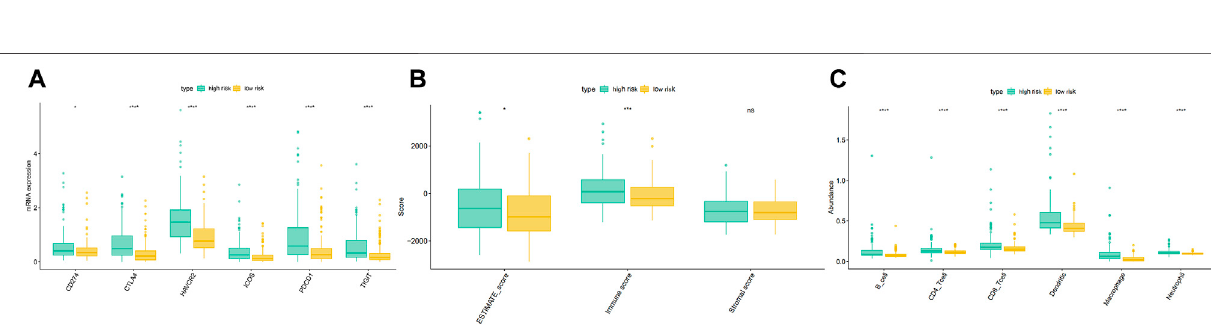
Frontiers in Pharmacology |